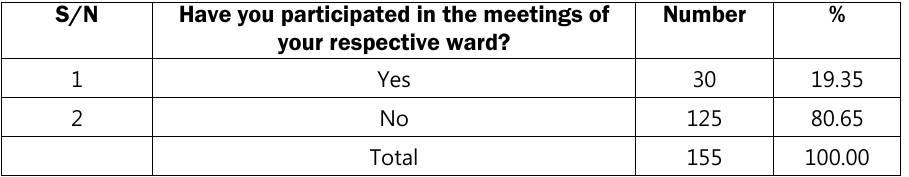
TABLE 7: Citizens’ views about participating in the informal meetings of their wards S/N Have you participated in the meetings of Number your respective ward?